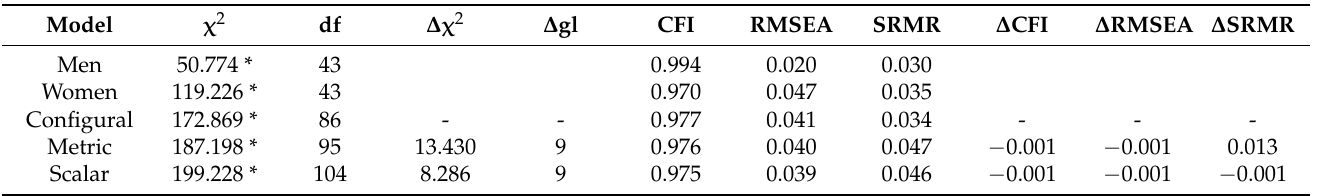
Table 2. Measurement invariance models of the 3-item version of the SWLS Flourishing Scale by gender (reference group: